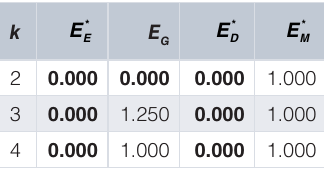
Table 9. Average error size (when wrong) over n = 200